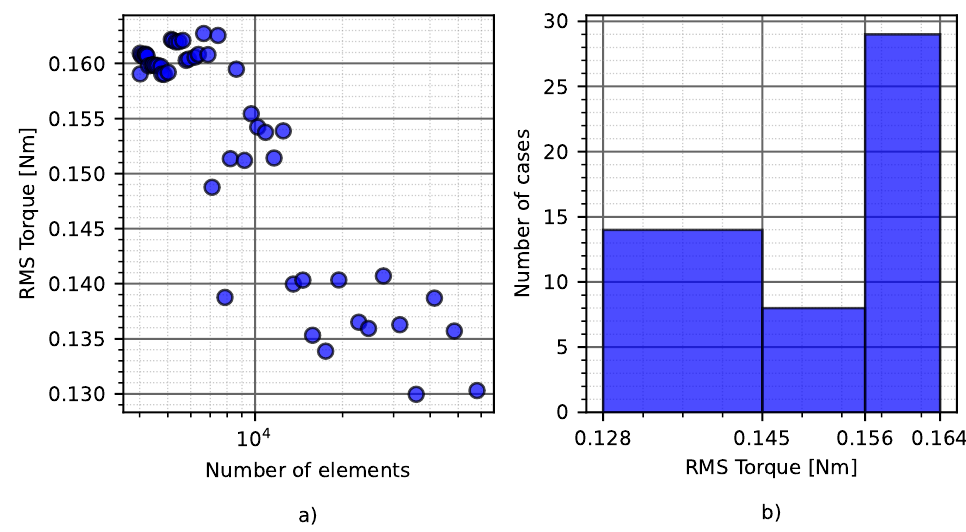
Figure 11. The root mean square torque in relation to the number of elements. ( a ) The RMS torque in each simulation, ( b ) the distribution of the